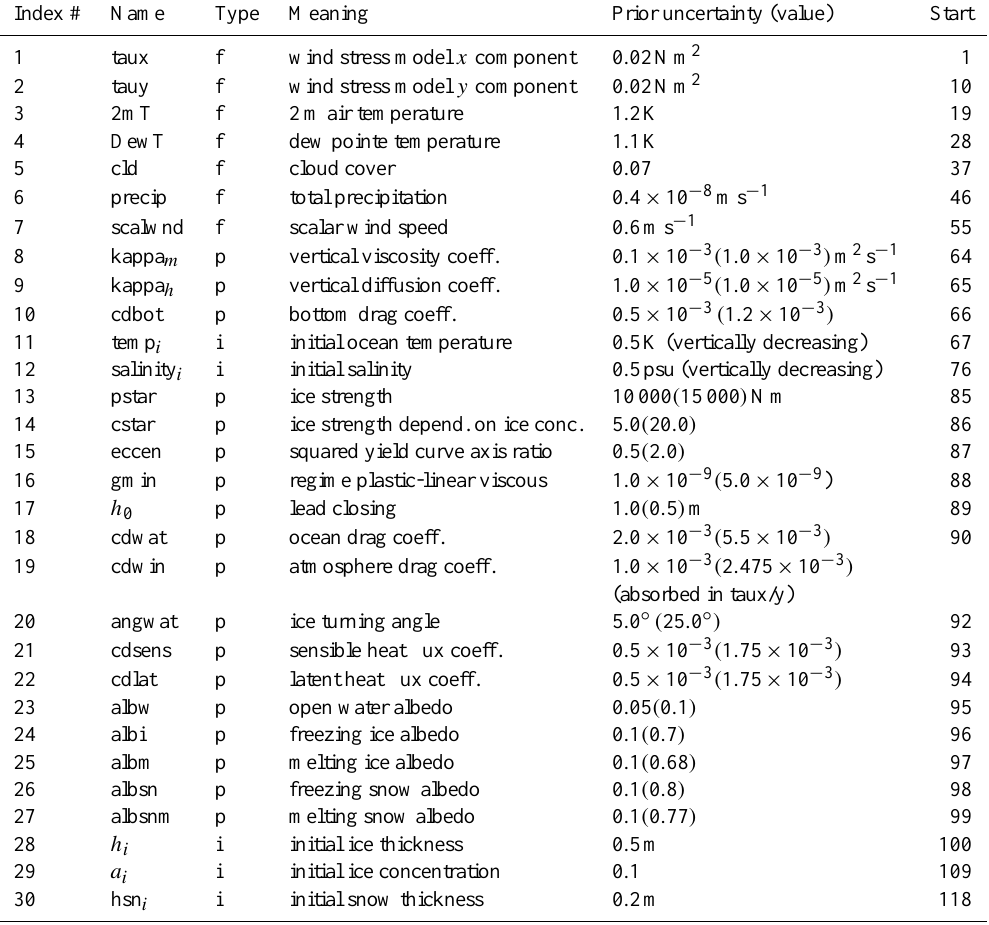
Table 1. Control variables. Column 1 lists the quantities in the control vector; column 2 gives the abbreviation for each quantity; column 3 indicates whether the quantity is an atmospheric boundary (forcing, i.e. f) field, an initial field (i), or a process parameter (p); column 4 gives the name of each quantity; column 5 indicates (the standard deviation of) the prior uncertainty and the corresponding units and provides the magnitude of the parameter value in parenthesis, where applicable; and column 6 identifies the position of the quantity in the control vector – for initial and boundary values (which are differentiated by region) this position refers to the first region, while the following components of the control vector then cover regions 2 to